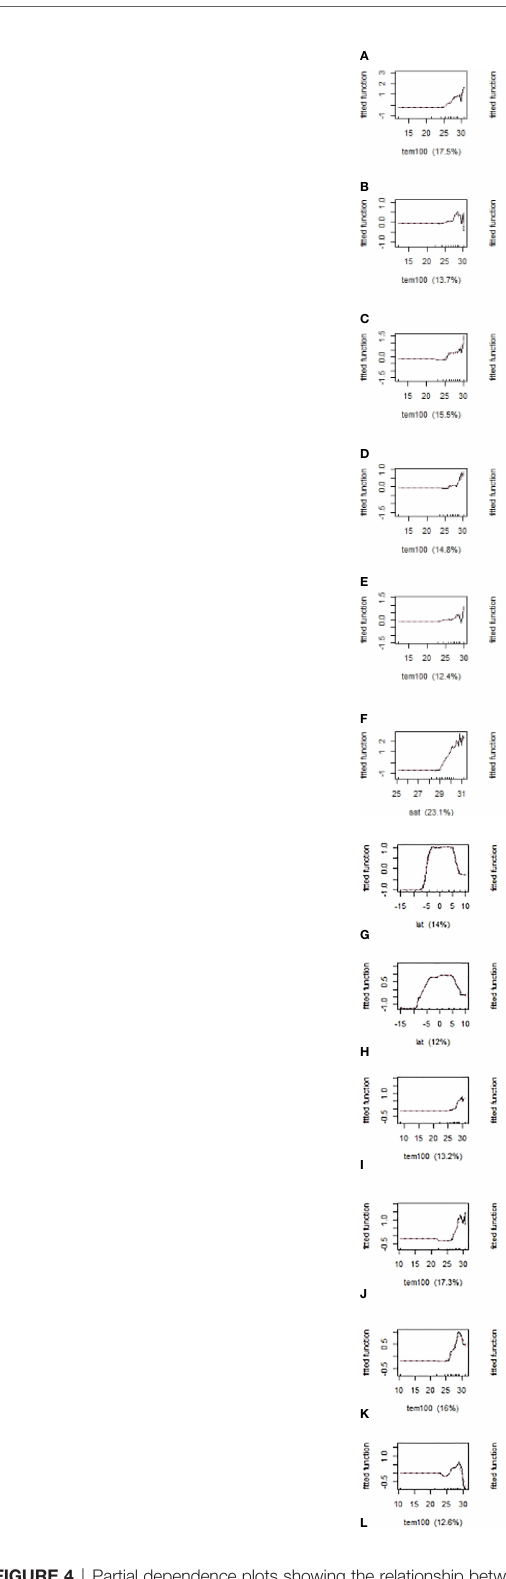
FIGURE 4 | Partial dependence plots showing the relationship between the environmental changes and fi shing behaviour. (A – L) here refers to the months from January to